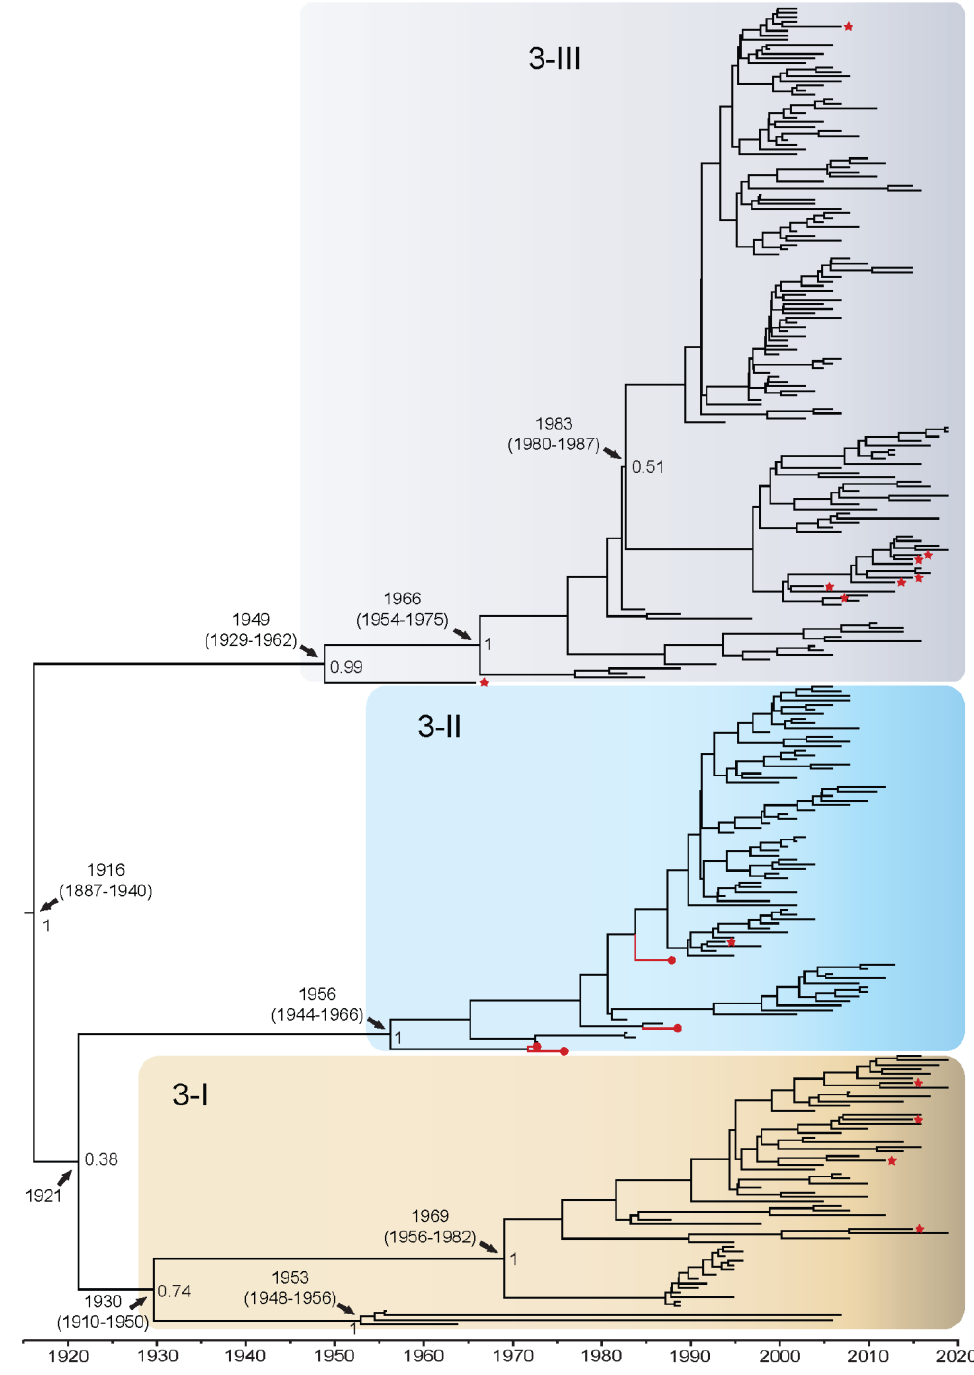
Figure 3. Bayesian phylogenetic tree from analysis of DENV3 whole genome complete coding sequences. Scale axis is representative of calendar years. Posterior node support is indicated for the major branches, with values <0.8 eliminated in most instances for clarity. Red circles indicate newly sequenced isolates from the QUT Arbovirus collection. Branches under positive selection (see Section 3.2.2) are indicated by red stars.